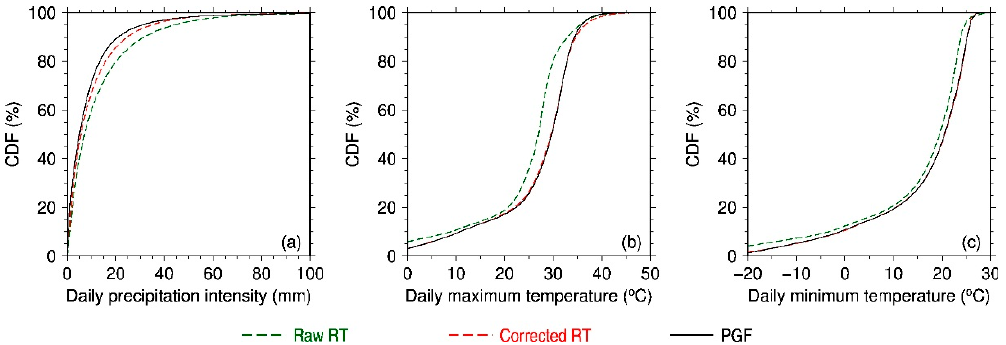
Figure 7. Comparisons of cumulative density function (CDF) derived from the raw RT data (dark-green dash line), corrected RT data (red dash line), and the gauge-based PGF data (black solid line) during 2001–2010, for ( a ) daily precipitation intensity ( P ), ( b ) daily maximum temperature ( Tmax ), and ( c ) daily minimum temperature ( Tmin ). Note that the raw and corrected RT data refer to the TMPA-RT and NCEP-NCAR reanalysis products.